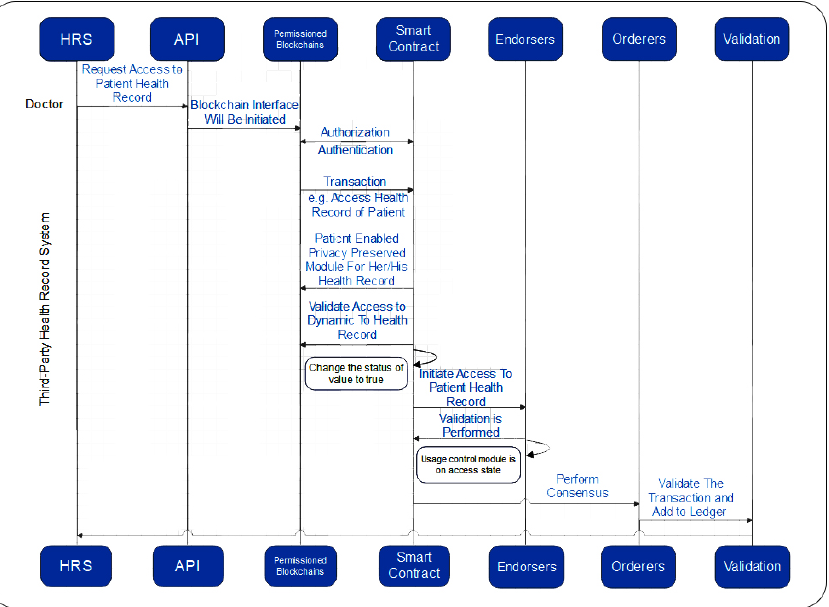
Figure 3. Sequence diagram for accessing the health record of a patient by health personnel, such as a doctor.